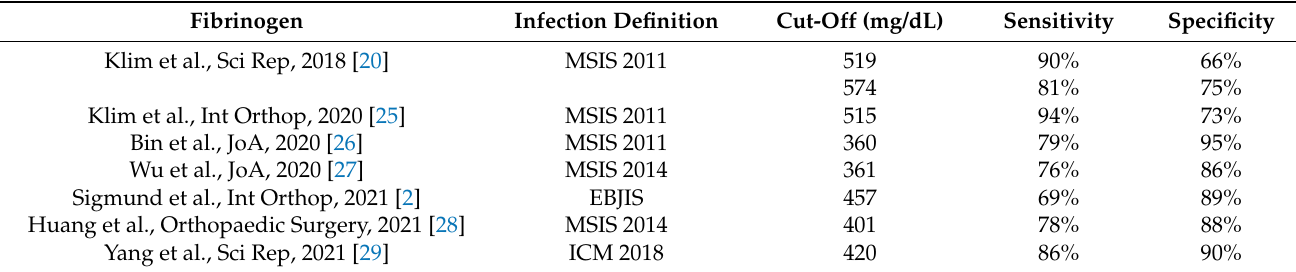
Table 4. Comparison of the literature regarding serum fibrinogen in the diagnosis of periprosthetic joint infection.